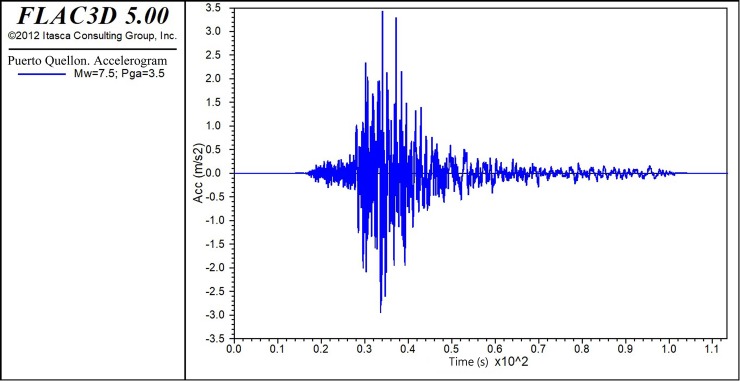
Puerto Quellon (PQ) input accelerogram.